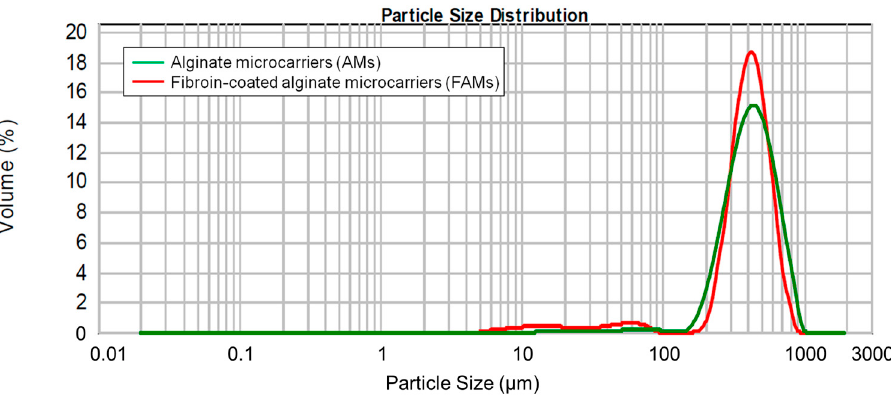
Figure 3. An illustrative particle size distribution of alginate microcarriers (AMs) (green line) and FAMs (red line). Data are reported as volume percentage values.